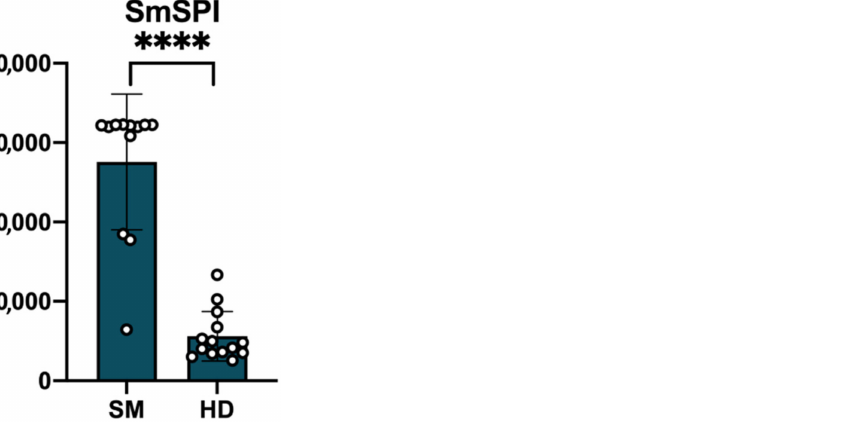
Figure 3. Unpaired t -Test results for the SmSPI specific human IgG. Protein arrays were probed with sera from Schistosome patients (N = 12) and control patients (N = 14). Significative: p < 0.05; **** p <